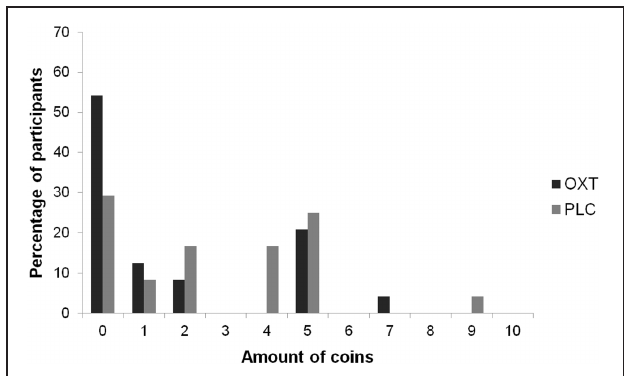
FIGURE 3 | Distribution of Dictator allocations after OXT vs. PLC